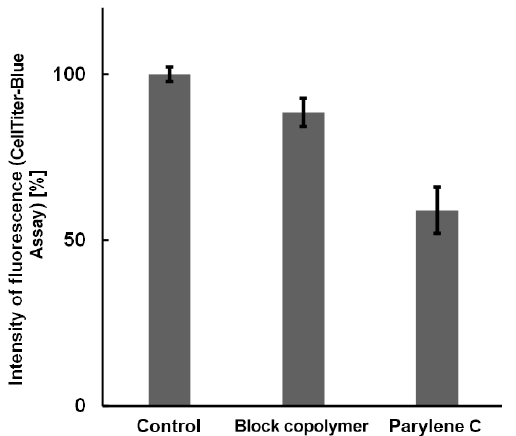
Figure 8. Fluorescence intensity (CellTiter-Blue Assay) as an indi- cator for the cell viability after the direct incubation on the coated biomaterials ( n = 6).